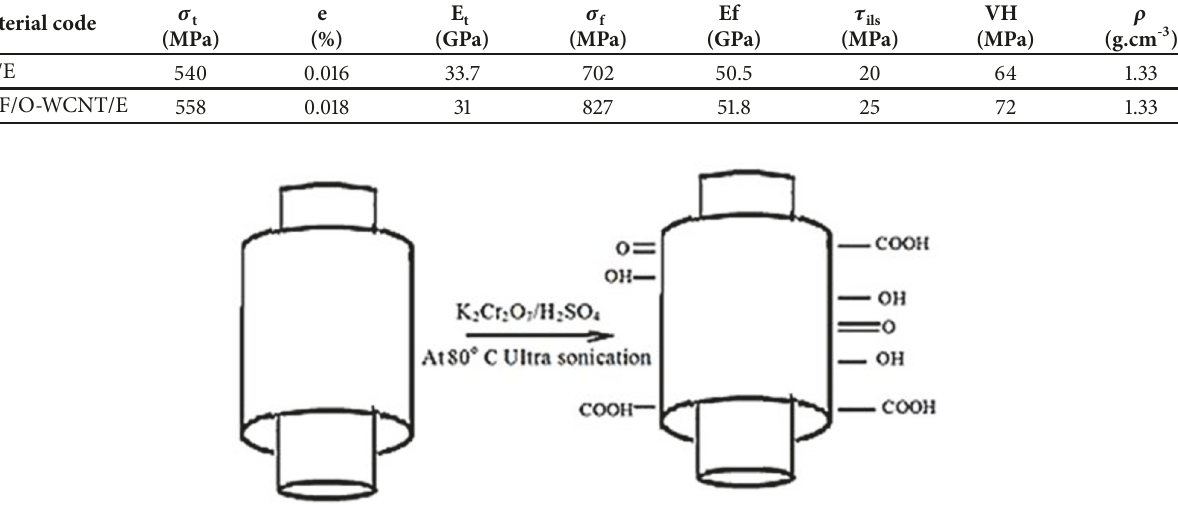
Figure 4: Schematic of the oxidation of MWCNTs by chromic acid.